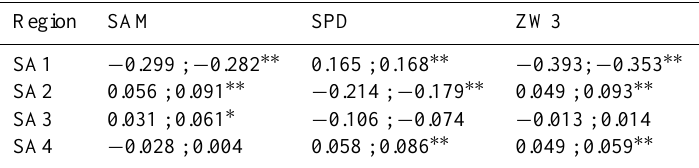
Table 3. Same as Table 2 but for precipitation.